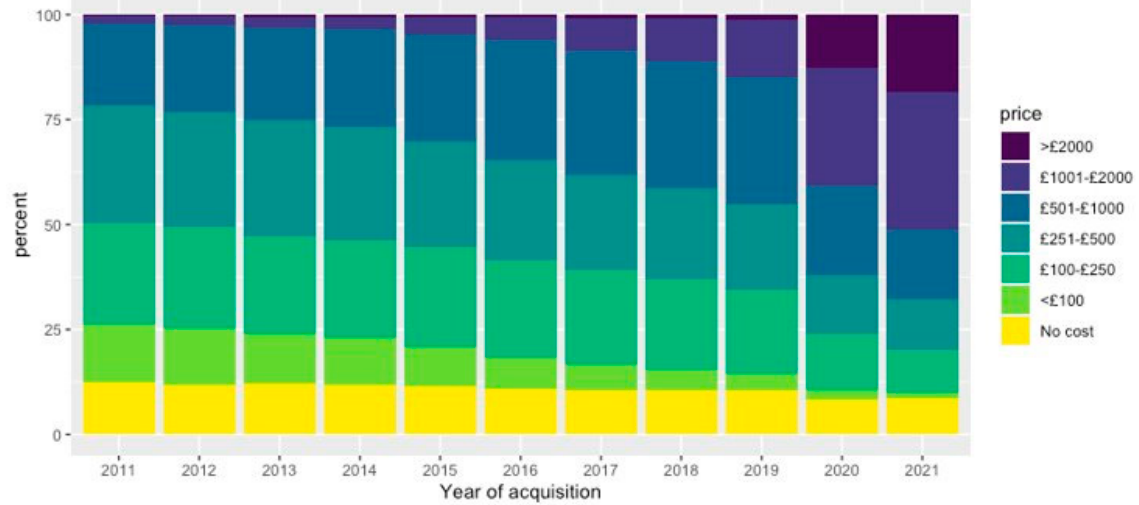
Figure 3. Chart summarising the price paid for dogs in the UK broken down by year. The purebreds that most commonly cost >GBP1000 included the Miniature Dachshund (54.2%), French Bulldog (54.1%), Golden Retriever (39.4%), Boxer (34.6%) and Pug (26.1%). Common crosses costing more than GBP1000 included the poodle mixes Cockerpoo (38.0%) and Labradoodle (33.2%) (Table S6). The cost paid for a dog also varied by source from which the owner acquired their dog (Table S7). Between 2016 and 2019, owners acquiring their dog via ‘Charity’ sources (including the website of a UK or foreign rehoming charity or a visit to a rehoming centre) most commonly paid between GBP100 and 250. During 2020–2021 this increased to GBP251–500. For those acquiring from ‘Breeder’